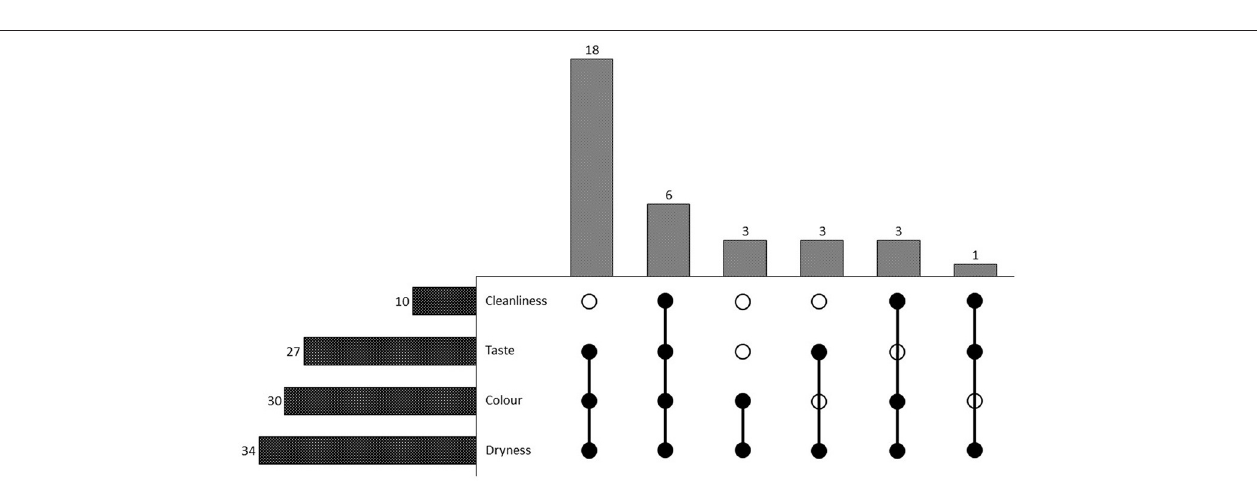
FIGURE 4 | Upset plot of important quality factors for baobab fruit pulp indicated by respondents handling this product across the value chain ( n = 34). The bar chart on the left indicates the overall frequency of the respective quality factor mentioned, whereas the bar chart above illustrates the frequency of quality factor